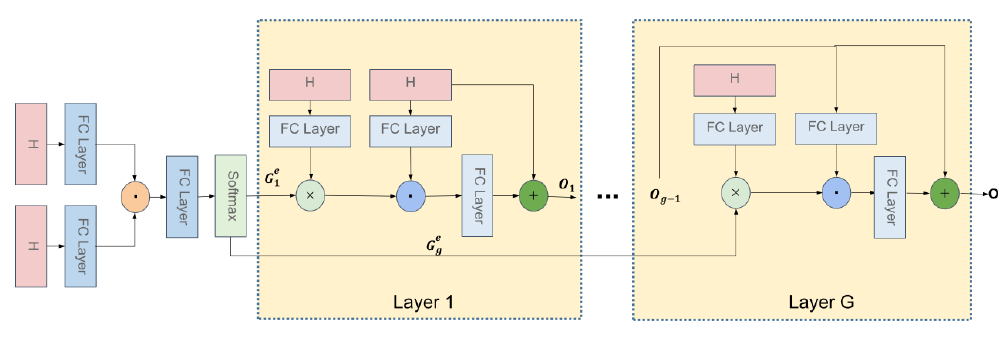
Figure 4. Architecture of our Multi-glimpse Bilinear Self-Attention